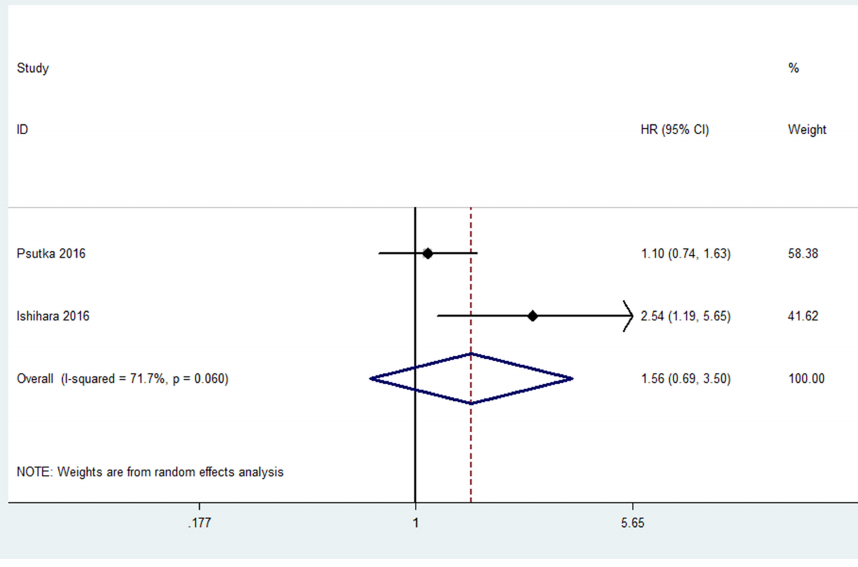
Figure 3 - Meta-analysis of the association between sarcopenia and PFS in patients with RCC.